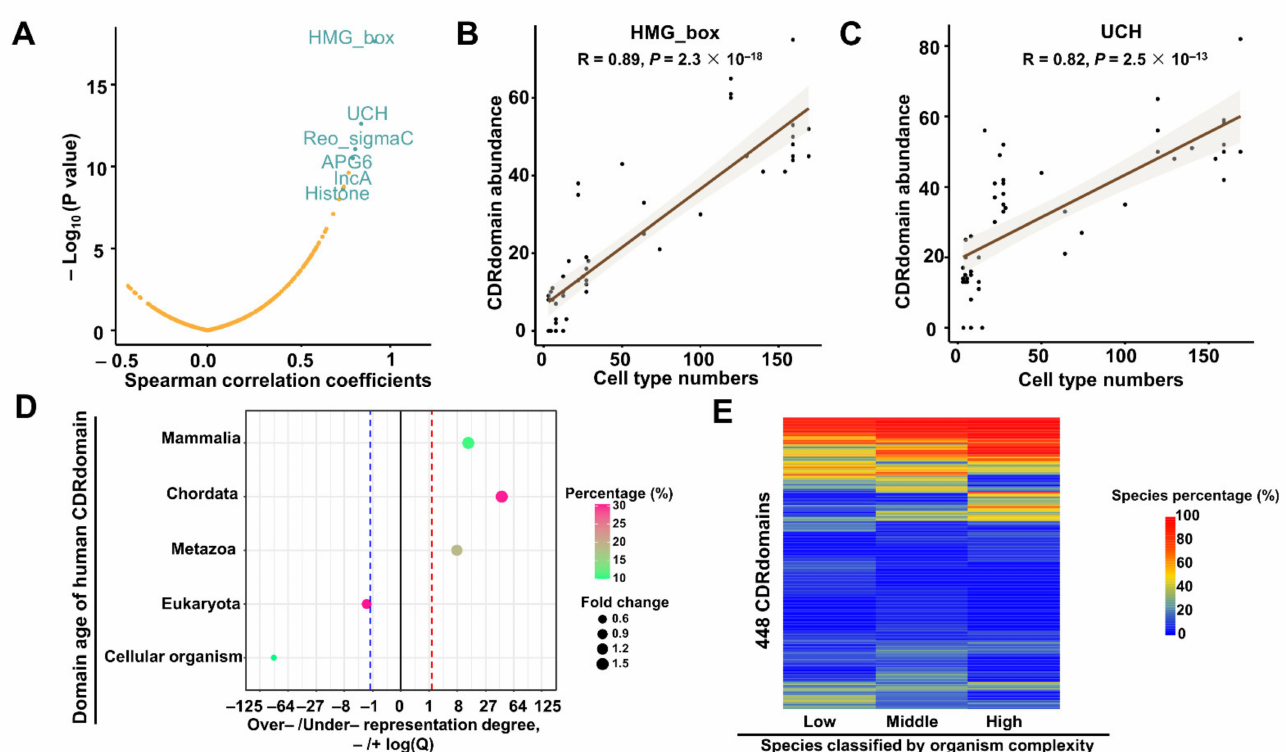
Figure 6. The contribution of the protein domains containing CDRs to organism complexity. ( A ) The domain abundance is the number of the genes encoding proteins containing this domain in one genome. The Spearman correlation coefficients (R values) were calculated between each CDR domain abundance and the organism complexity measured by cell-type number. The scatter plot shows the correlation between the Spearman correlation coefficients and p -values. The names of six representative protein domains (R > 0.7, the number of species where the domain has no CDR is less than 10) are shown. Two examples HMG_box ( B ) and UCH ( C ), are shown by the scatters representing the correlation between domain abundance in one genome and cell-type number of species. ( D ) Over- or under-representation strengths of the human CDRdomains in five domain age grades. Over- and under- representation are represented by –log(P) or log(P), respectively (see Methods for details). The red/blue dashed line represents the –/+log(P) value corresponding to significant over- or under-representation. The percentage of the domains with a certain age is marked as gradual colors. Fold change, represented by the size of the circle, means the ratio of the number of domains of each age grade to the proportional expected value. ( E ) Clustered heat map shows the percentages of the species where the domain contains a CDR in each complexity group for the 448